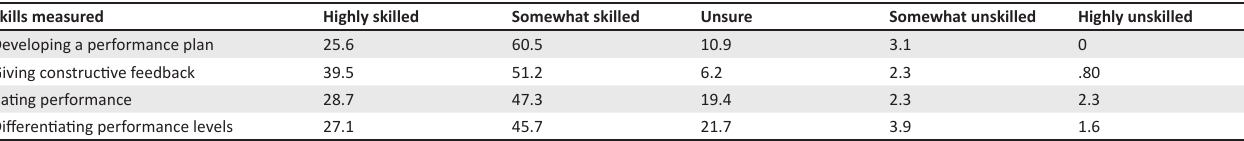
TABLE 3: Self-rating of performance management skills (line managers).